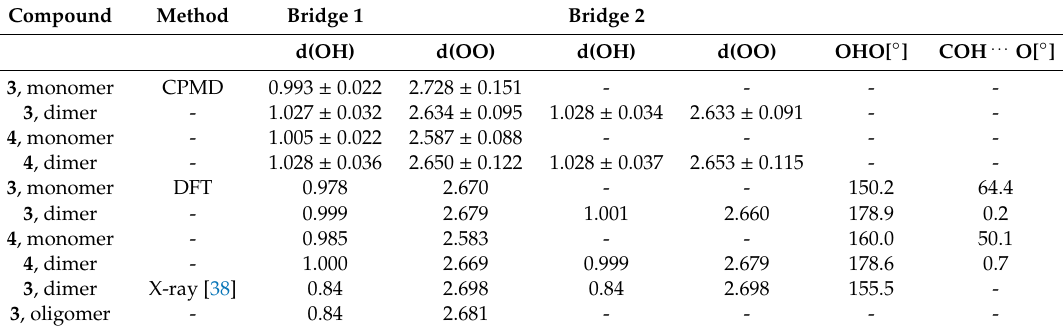
Table 1. Metric parameters (in Å) for the donor-acceptor (OO) and donor-proton (OH) contacts in the monomers and dimers of 3 and 4 . The CPMD results are given as: Average ± standard deviation.